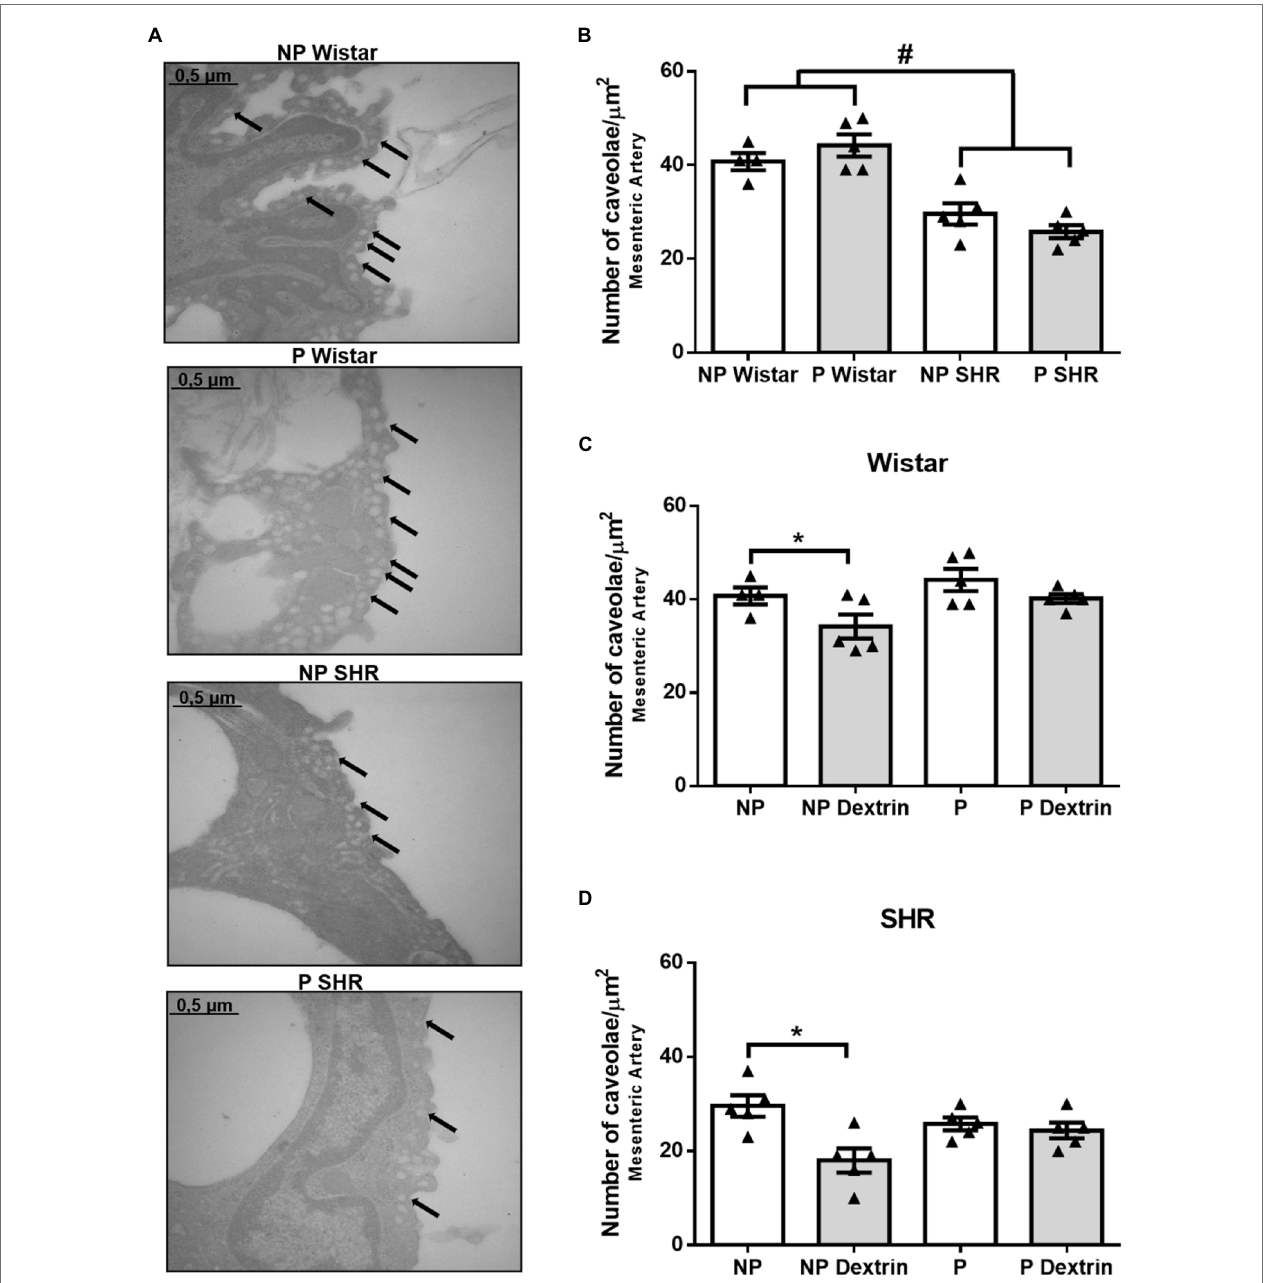
FIGURE 4 | Representative photomicrographs (50,000× magnification, in (A) and quantification of the number of endothelial caveolae/ μ m 2 in resistance mesenteric arteries of non-pregnant (NP) and pregnant (P) Wistar and spontaneously hypertensive (SHR) rats (B) in the presence of vehicle or dextrin (10 mmol/L, C,D ). The bars represent the mean ± SEM of the results obtained in the resistance mesenteric artery ( n = 5) from the different groups. # p < 0.05 NP SHR and P SHR versus NP Wistar rats and P Wistar rats; * < 0.05 NP dextrin versus